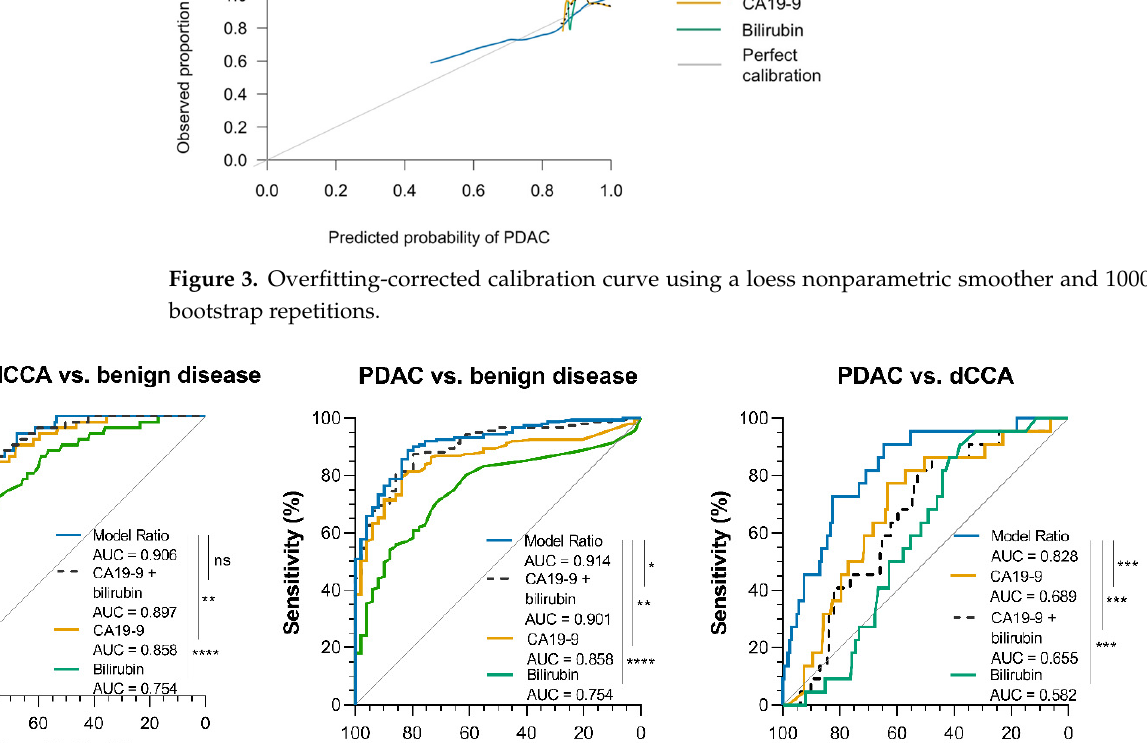
Figure 3 Overfitting-corrected calibration curve using a loess nonparametric smoother and 1000 bootstrap repetitions.